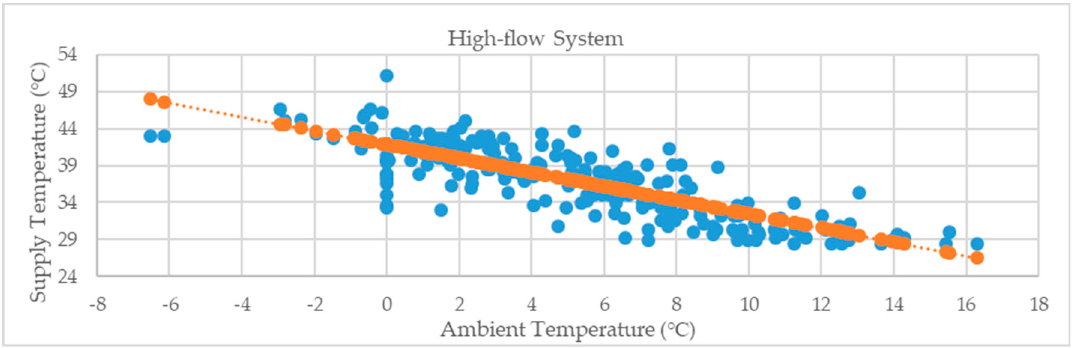
Figure 12. The proposed weather compensation control of the supply temperature (orange line) under low flow system operation presented via a linear regression analysis.